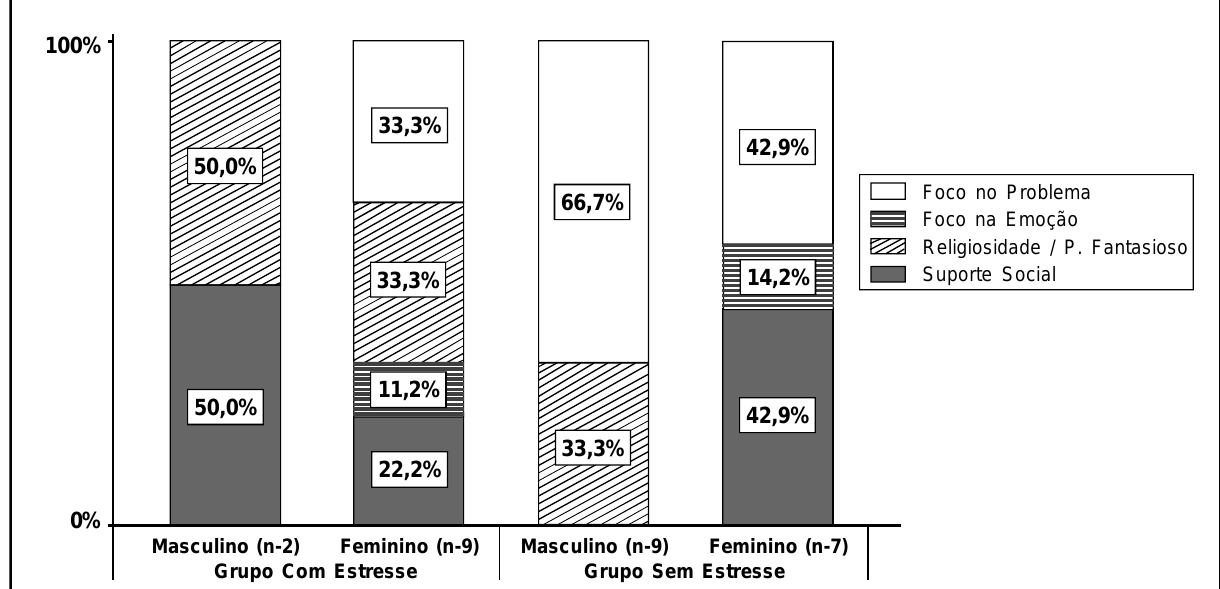
Figura 3. Principais estratégias de enfrentamento por sexo, segundo o diagnóstico de estresse ( n